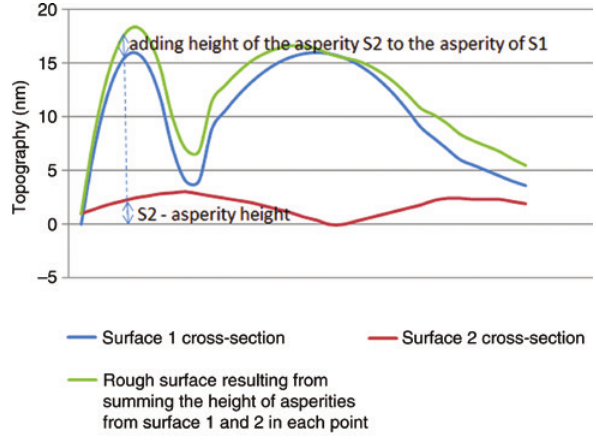
Figure 1: An example of a rough surface used for simulation, modeled in contact with a perfectly smooth surface. This rough surface is created by summing of the asperities of two real surfaces into